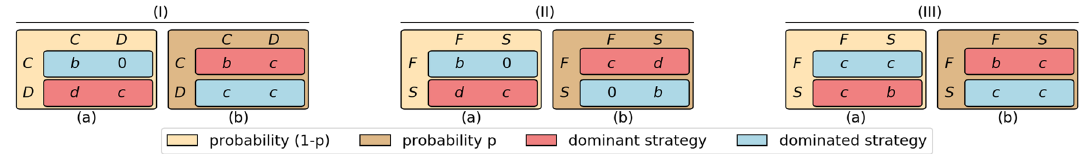
Figure 2. Payoff earned by the row player with b > c > 0 , and d = b + c .